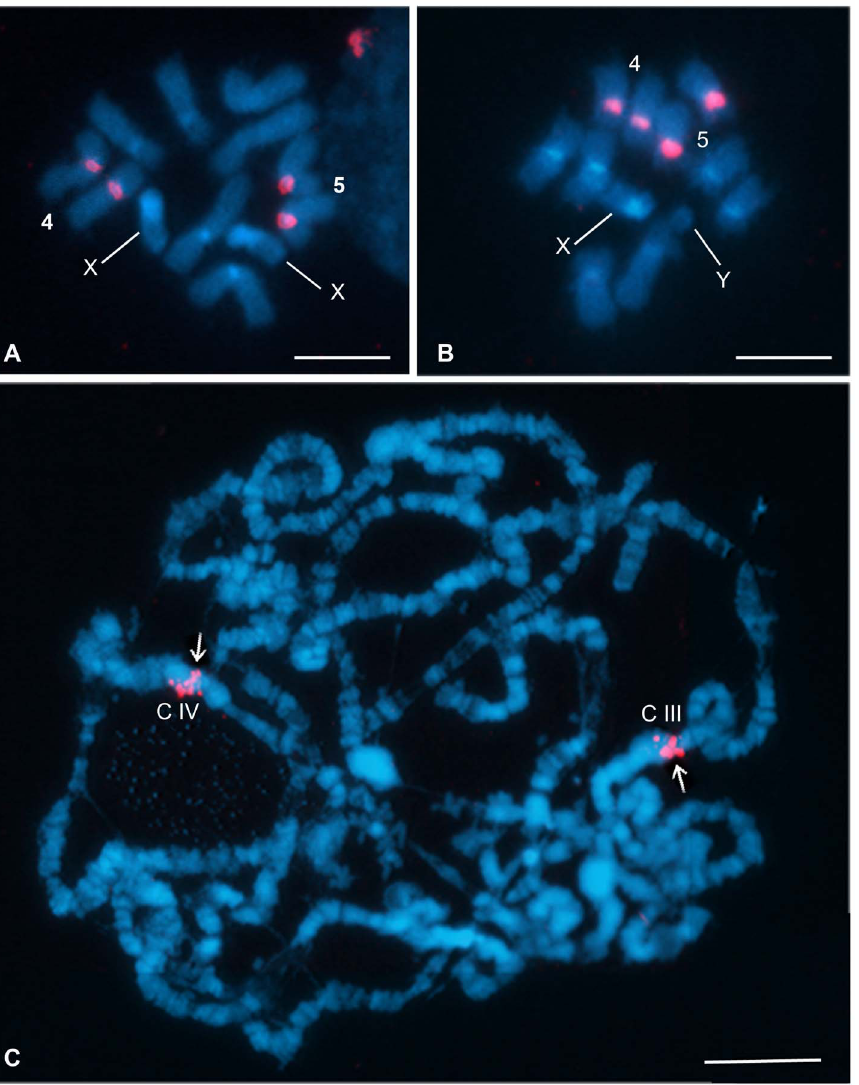
Figure 6. FISH with the BoR300 probe on mitotic and polytene nuclei of Bactroceraoleae. Chromosomes were counterstained with DAPI (blue). Female (a) and male (b) metaphase showing strong hybridization signals (red) on the centromeres of chromosomes 4 and 5. Polytene complement (c) showing strong hybridization signals (red) on the centromeric heterochromatic blocks (C) of chromosomes III and IV (arrows). Bar =3 m m (a, b), 20 m m (c).